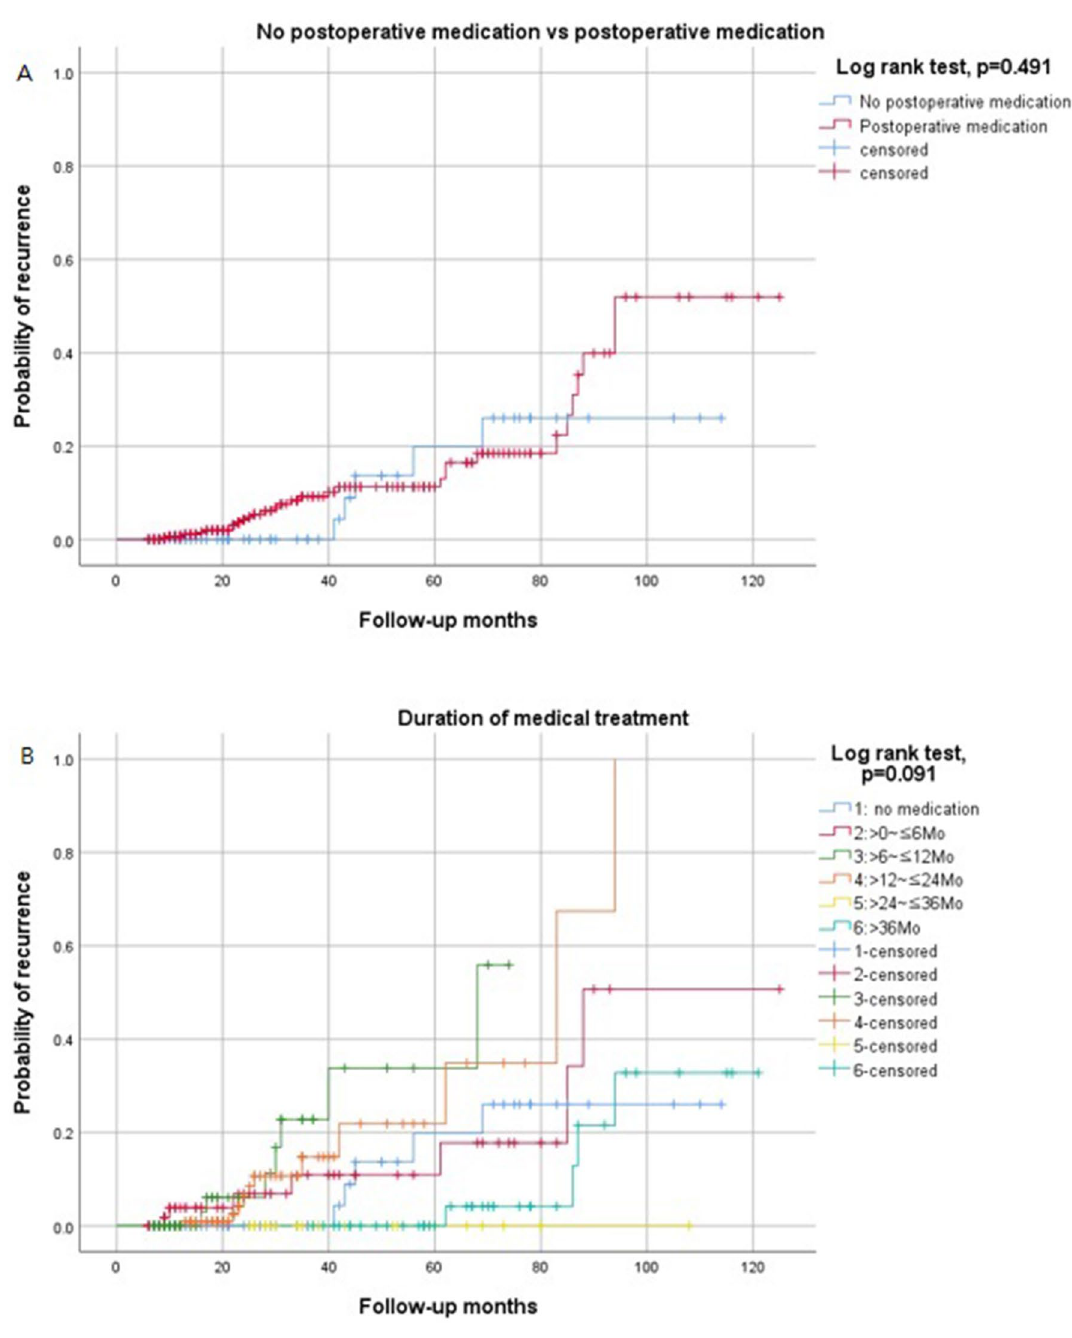
Figure 3. Probability of recurrence by Kaplan- Meire curve (Log-rank test) ( A ). no medication vs. postoperative medication ( B ). Duration of medican